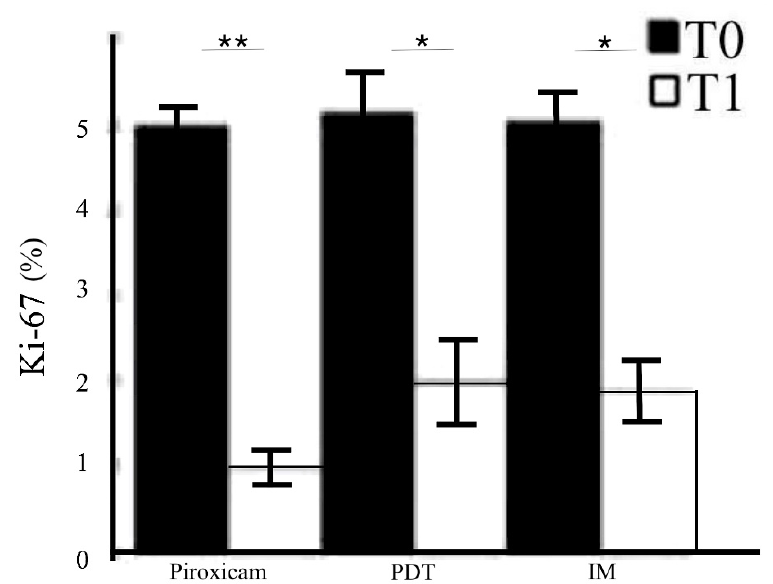
Figure 3. Immunohistochemical evaluation of the proliferation rate of the target lesions by Ki-67 before and after treatment. Semiquantitative evaluation of Ki-67 before and after medical device 0.8% piroxicam and 50+ sunscreen, photodynamic therapy (PDT), and ingenol mebutate (IM) gel. * p < 0.01; ** p < 0.001.